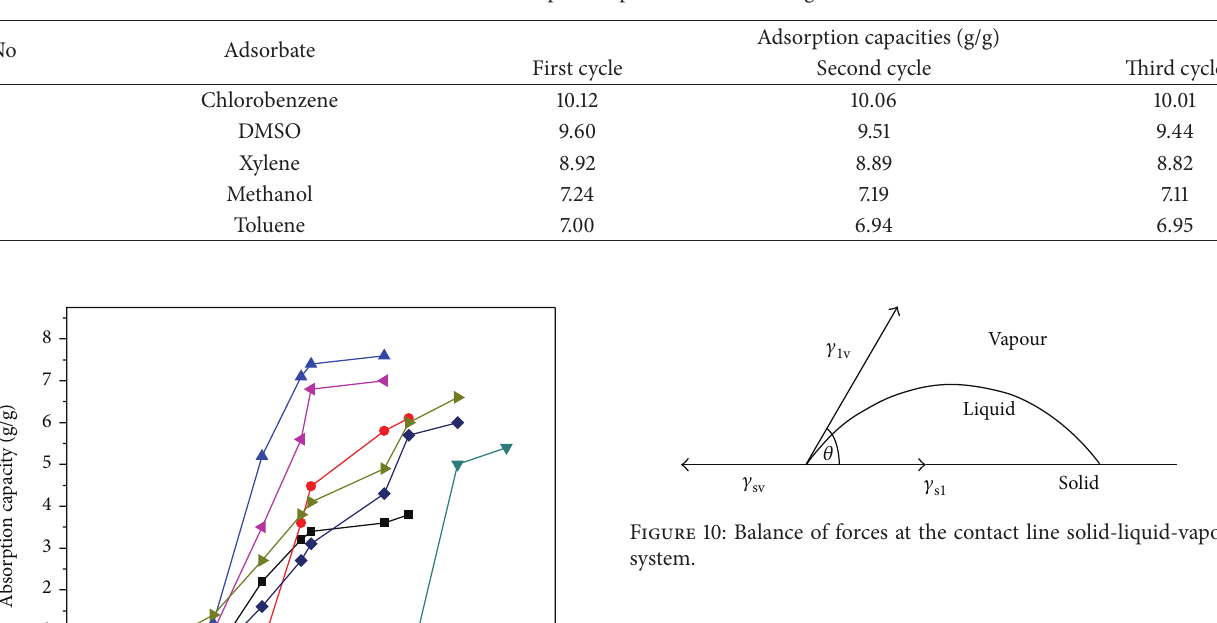
Figure 8: Images of aerogel adsorbing and desorbing toluene. Table 1: The adsorption capacities of silica aerogel.